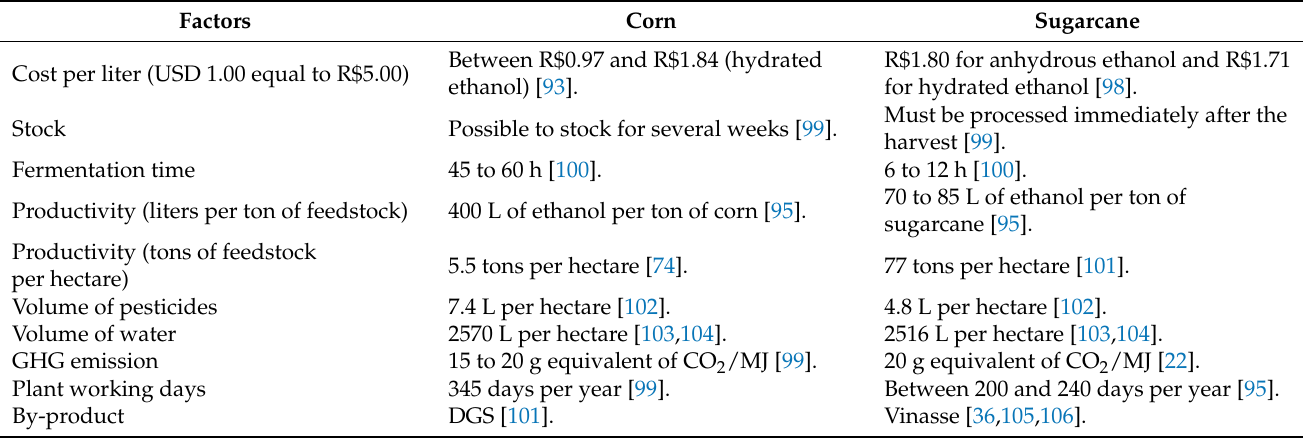
Table 1. Comparison between corn and sugarcane as feedstock for ethanol